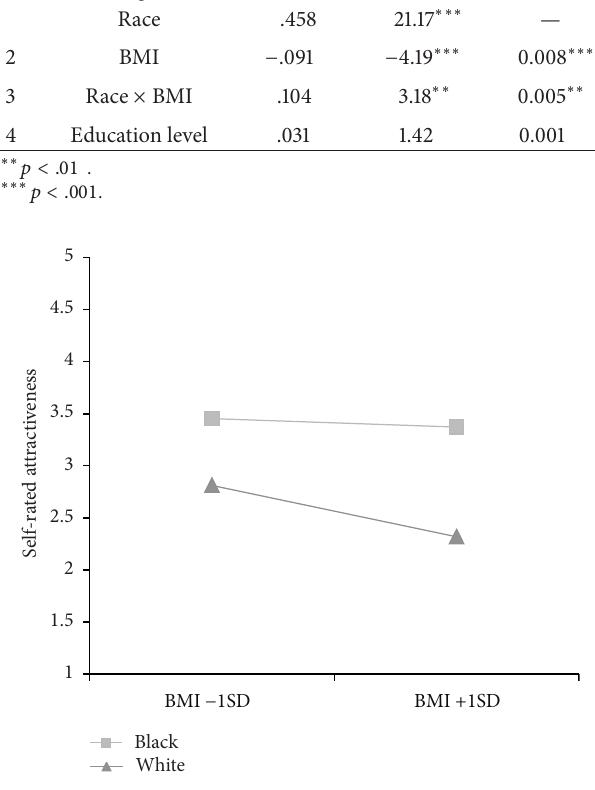
Figure 1: Attractiveness means by race and